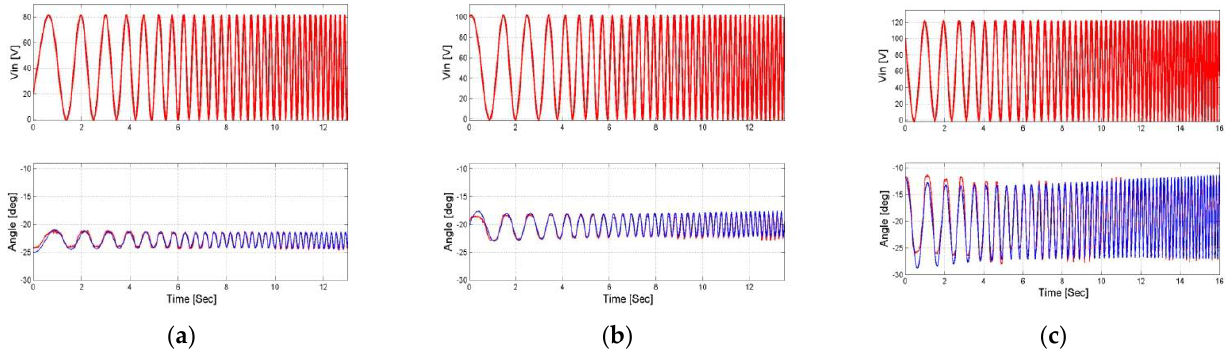
Figure 14. Comparison of uniform transfer function vs. measured output angle results when the first load is applied. ( a ) Vin = 80 V, ( b ) Vin = 100 V, and ( c ) Vin = 120 V.